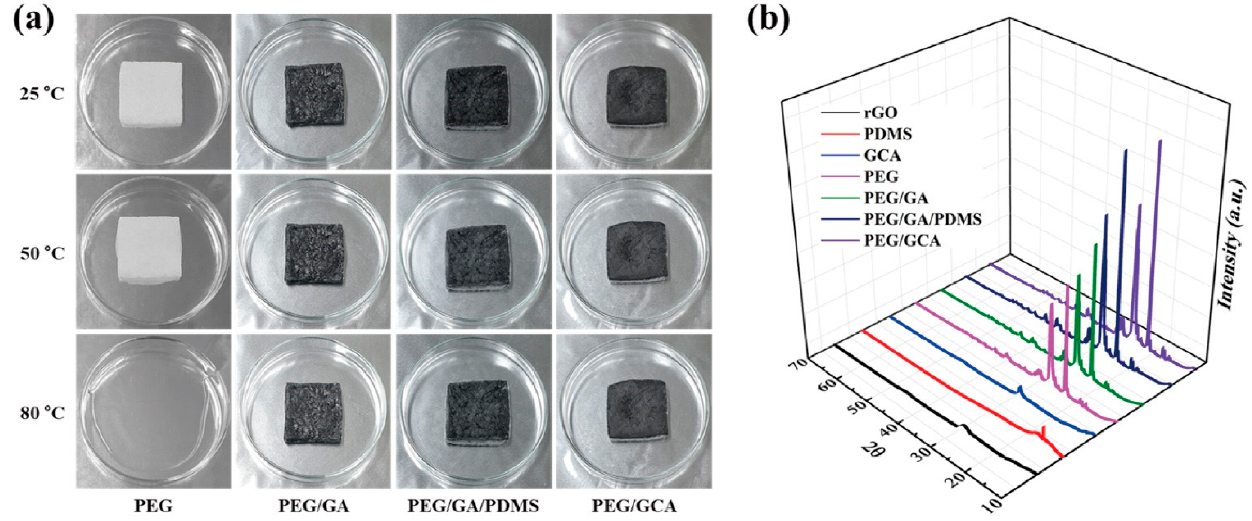
Figure 5. ( a ) Form-stable photographic images of pure PEG and PEG composites. ( b ) XRD peaks of supporting materials and PEG composites.